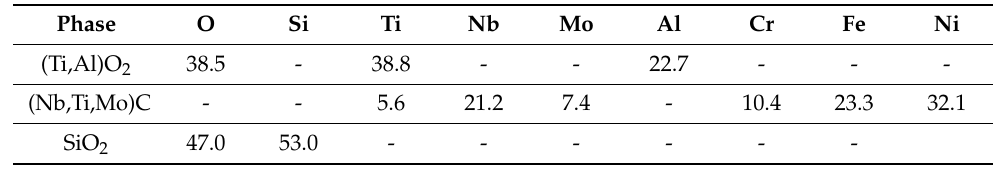
Table 2. EDX chemical composition (wt.%, normalized to 100%) of the non-metallic inclusions in LPBF 316L.